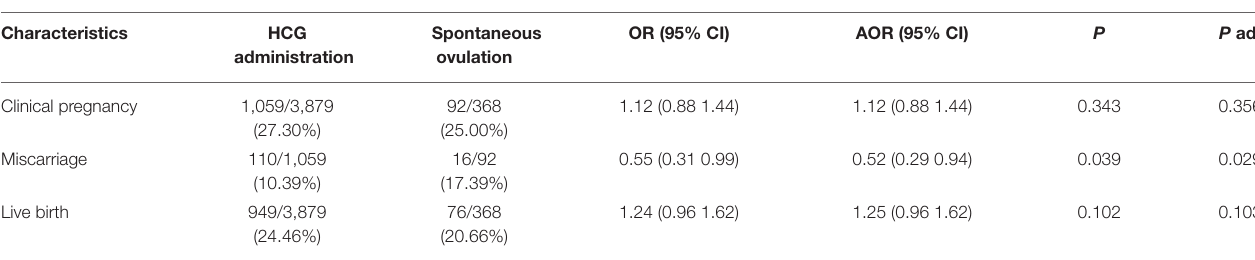
TABLE 4 | Reproductive outcomes of the double IUI